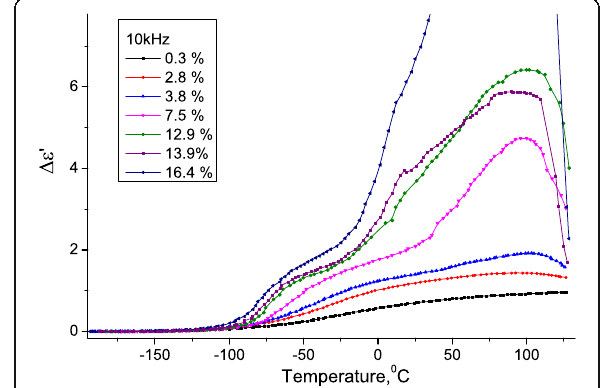
Fig. 10 Temperature dependence of the increment of real part of the dielectric permittivity MCC+2.8% H 2 O. Temperature dependence of the increment of real part ( Δ ε ′ = ε ′ ( T ) − ε ∞ , where ε ∞ ¼ ε ′ of the dielectric permittivity MCC+2.8% H 2 O on frequencies 5, 10, 20, and 50 kHz